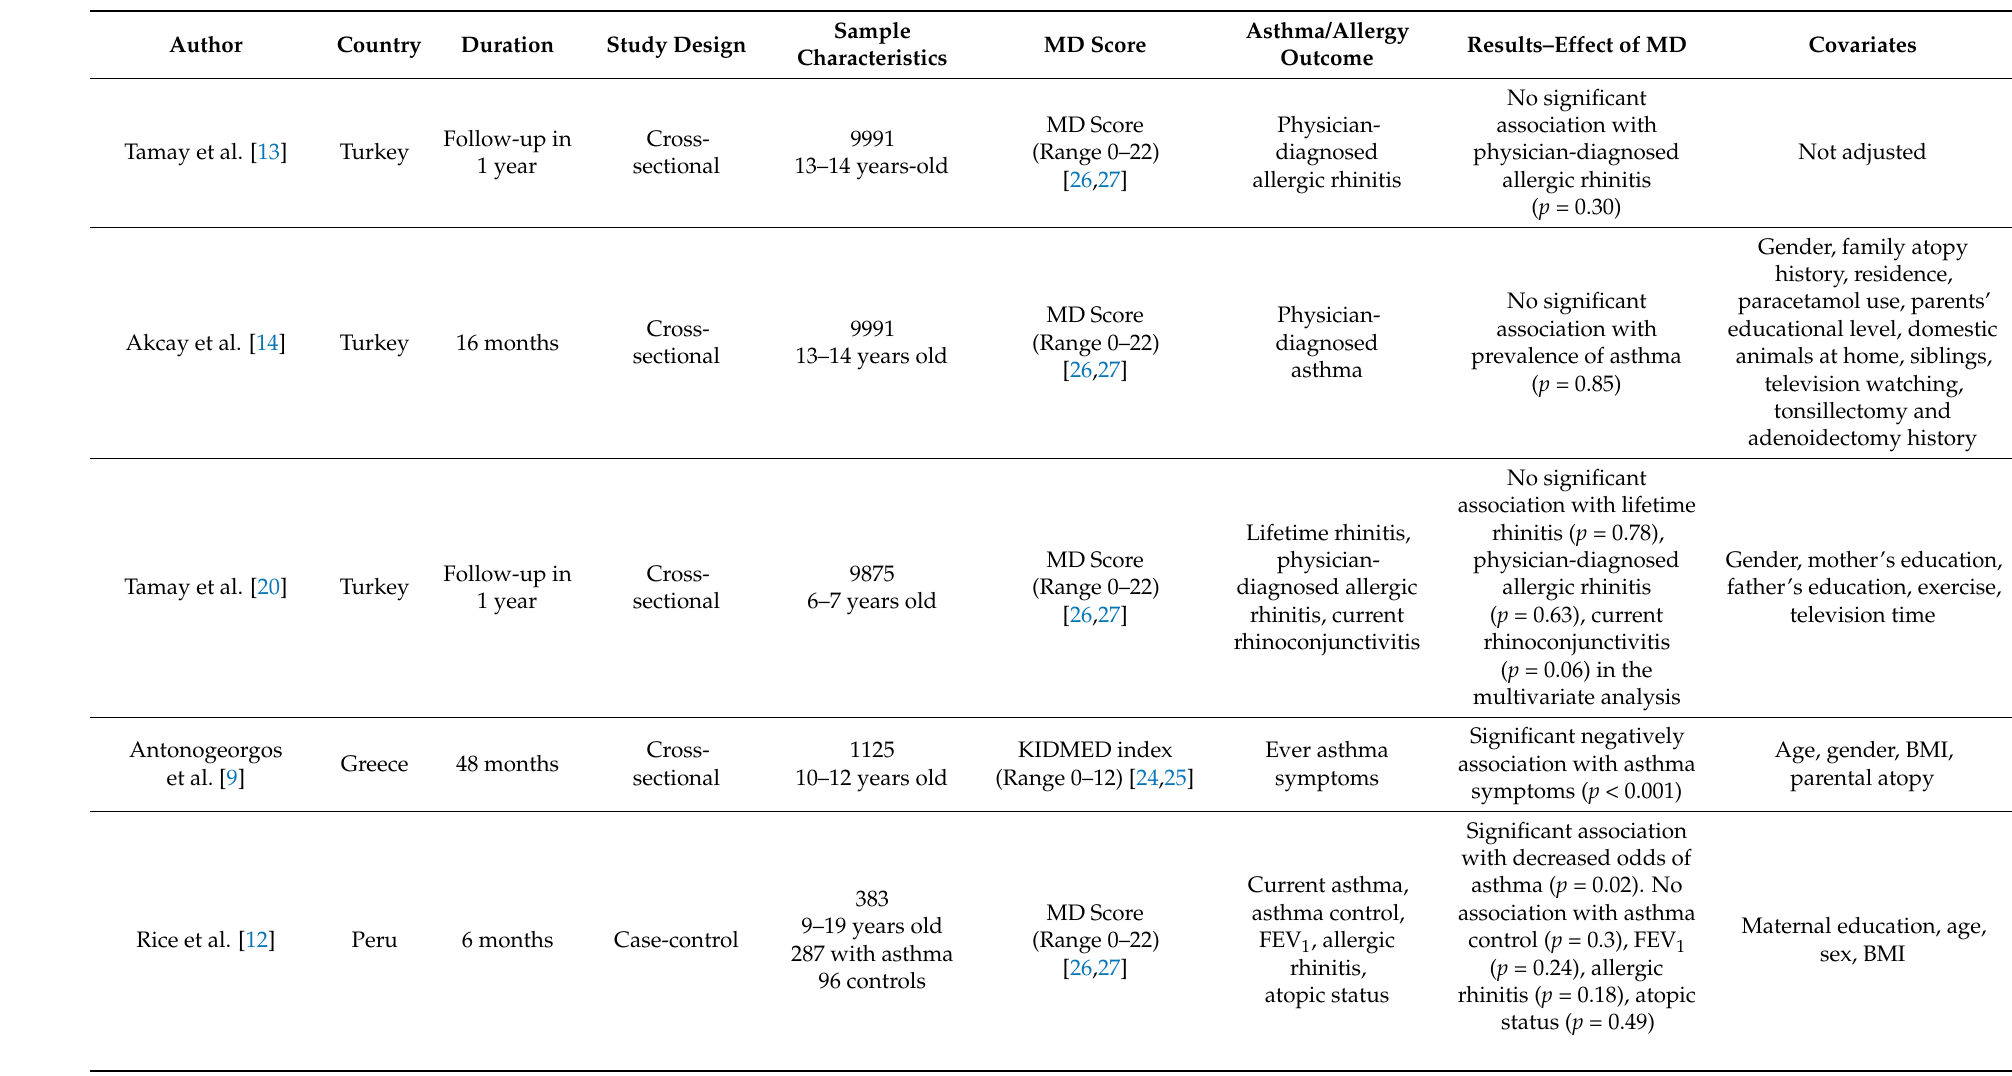
Table 1. Summary of studies’